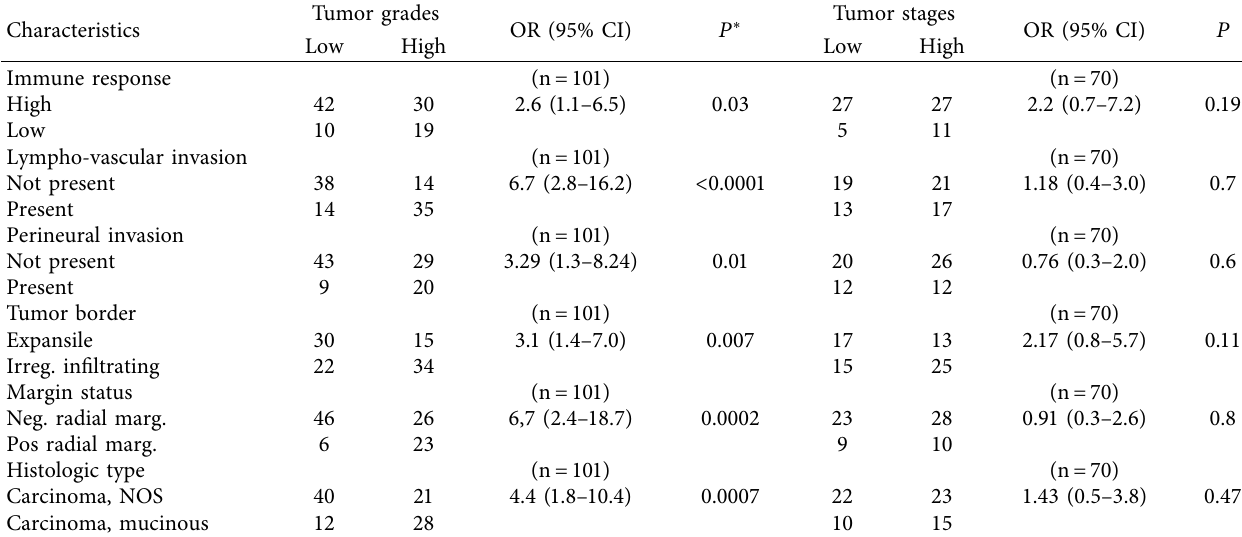
Table 5: Correlation between prognostic determinants and tumor grade and stage.